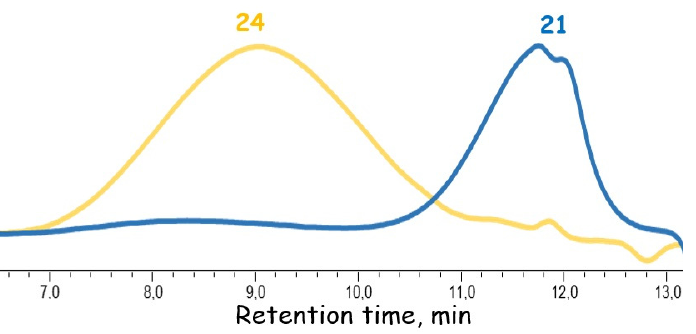
Figure 9. GPC curves obtained in Experiment 21 is the low molecular weight condensation product